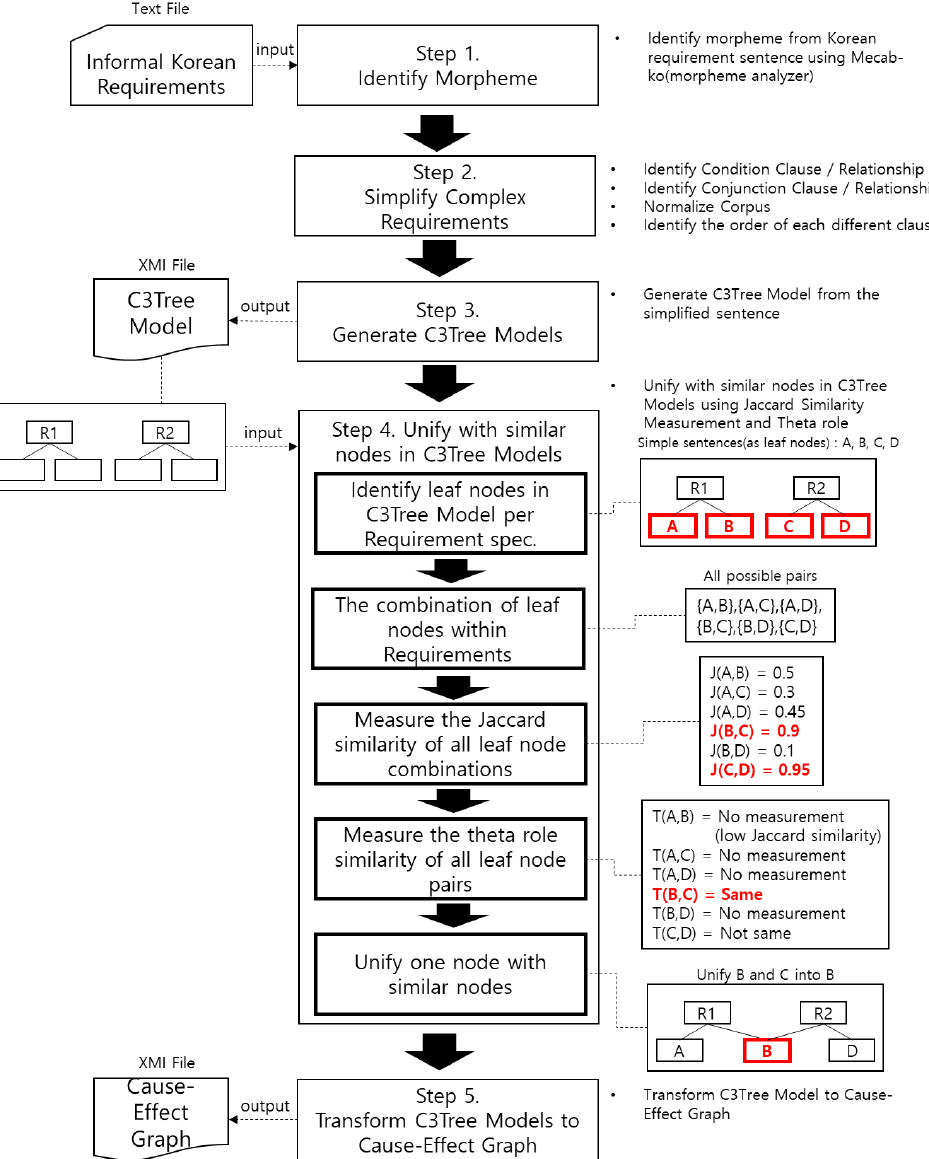
Figure 2. The cause – effect graph generation process based on informal Korean requirement specifi- Figure 2. The cause–effect graph generation process based on informal Korean requirement specifications. cations.